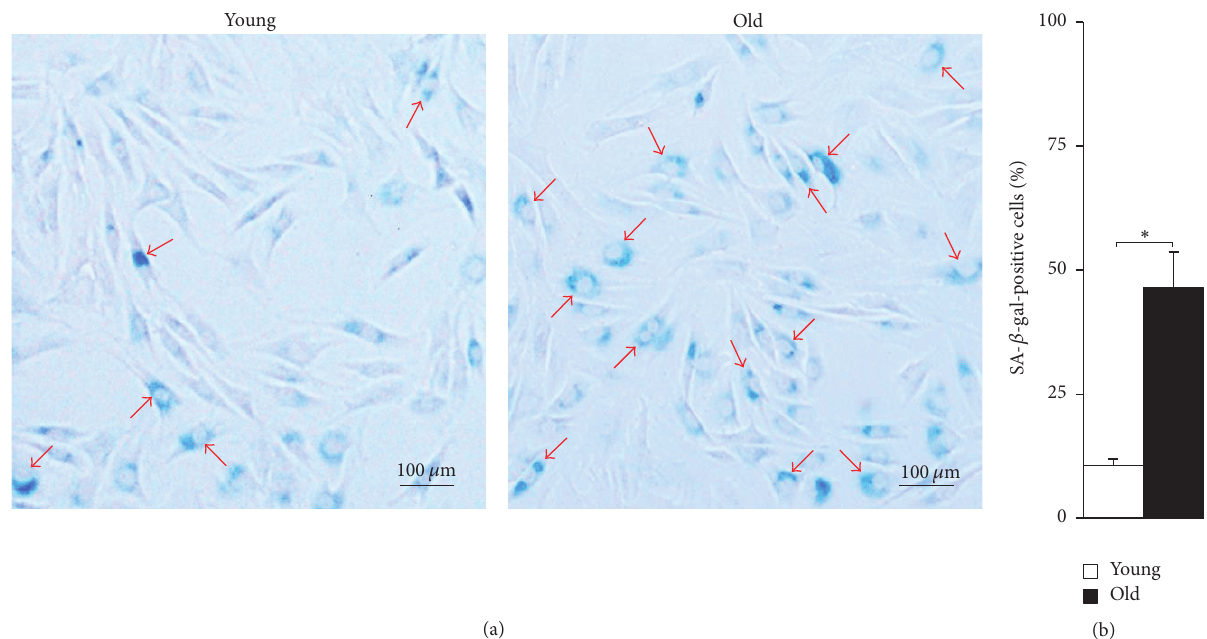
Figure 7: Cellular senescence in NPMSCs ( 𝑛 = 5 ). (a) Representative images of SA- 𝛽 -gal staining for the detection of senescent NPMSCs from young and old rats. An increased number of old NPMSCs were positive (blue color) for SA- 𝛽 -gal compared to young NPMSCs. (b) Quantitative analysis also showed that the percentage of SA- 𝛽 -gal-positive old NPMSCs was significantly higher than that of young NPMSCs. The data are expressed as means ± SD. ∗ indicates 𝑃 < 0.05 .